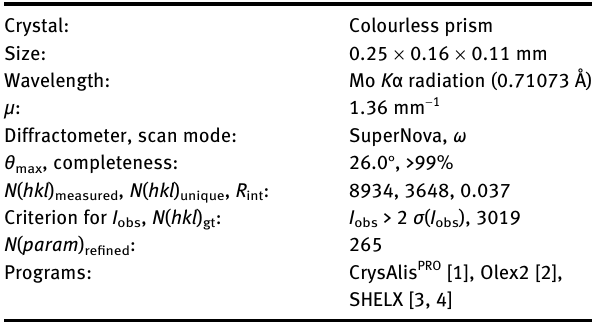
Table  : Data collection and